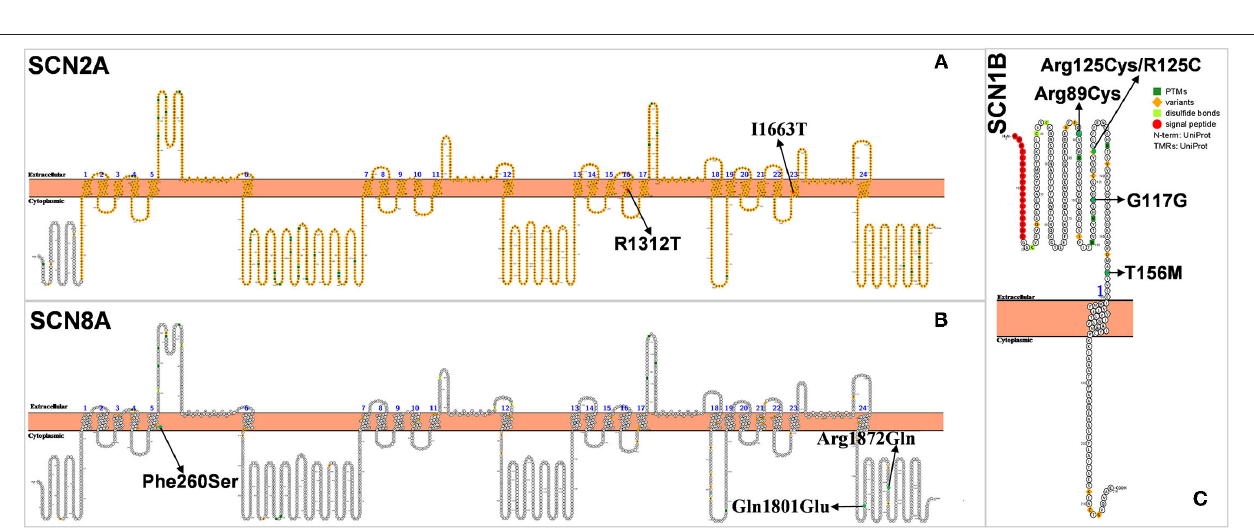
FIGURE 3 | Schematic diagram of protein encoded by PCDH19 , illustrating the location of the amino acids affected by the mutations identified in patients.